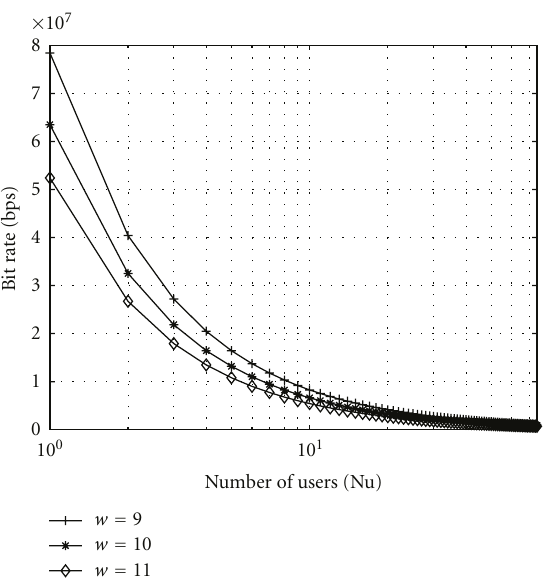
Figure 12: Influence of the number of users on the bit rate for 8- PIM and T c =